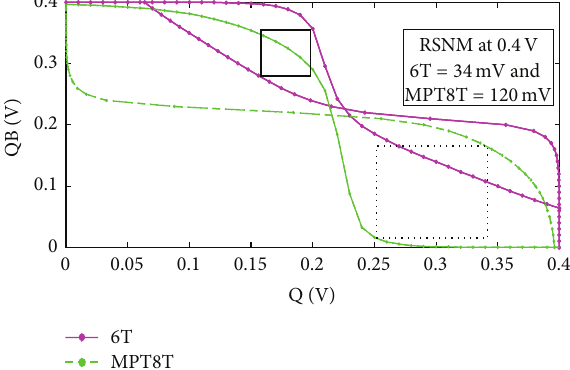
Figure 11: RSNM “butterfly curve” of MPT8T and